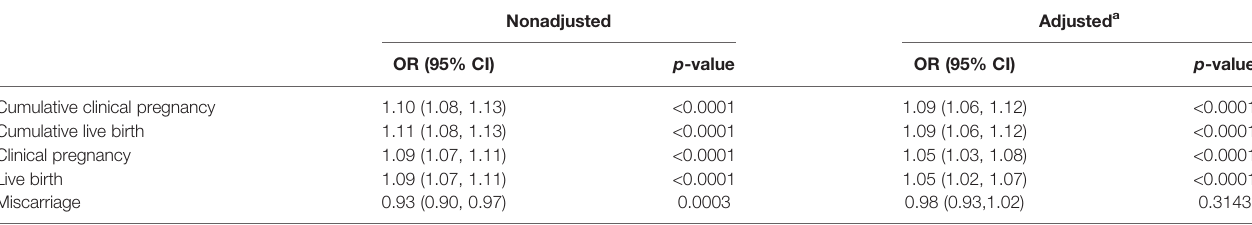
TABLE 3 | Number of oocytes retrieved and clinical